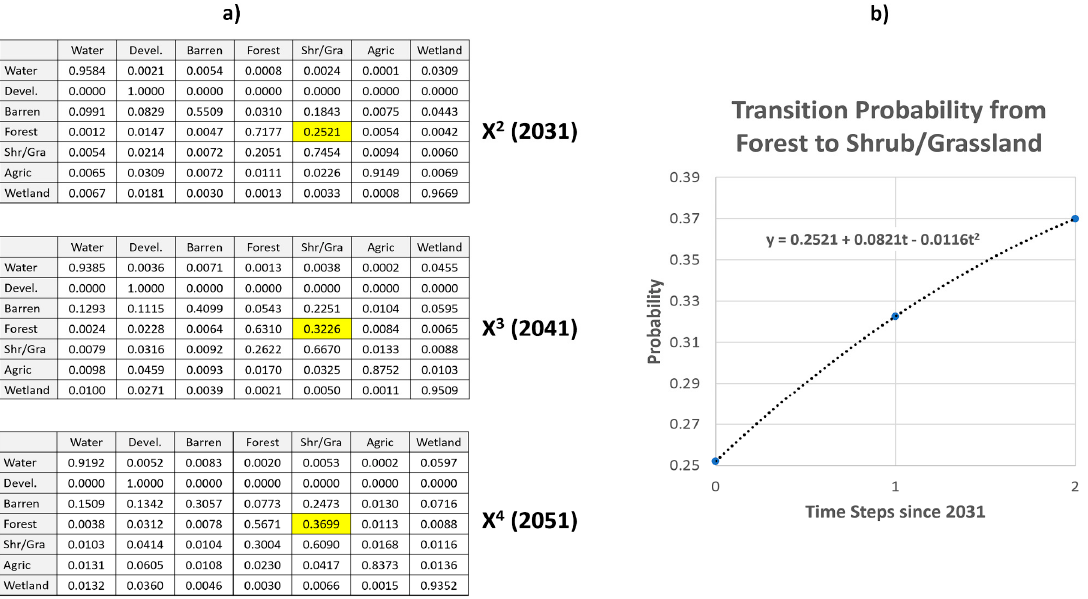
Figure 2. An illustration of the logic of the Regression-Based Markov (RBM) algorithm. ( a ) To estimate the transition probability from forest to shrub/grassland in 2035, the base matrix (Figure 1) is taken to the powers of 2, 3 and 4. In each matrix, the rows represent land cover in 2001 and the columns represent land cover at the later date specified. ( b ) The values in the three powered matrices (an example is highlighted in yellow) are then regressed against time expressed in 10-year steps from 2031. The value for 2035 would use the fitted equation using a value of 0.4 for the value of t (since 2035 is 4/10 of the time from 2031 to 2051). The predicted transition probability is 0.2831.